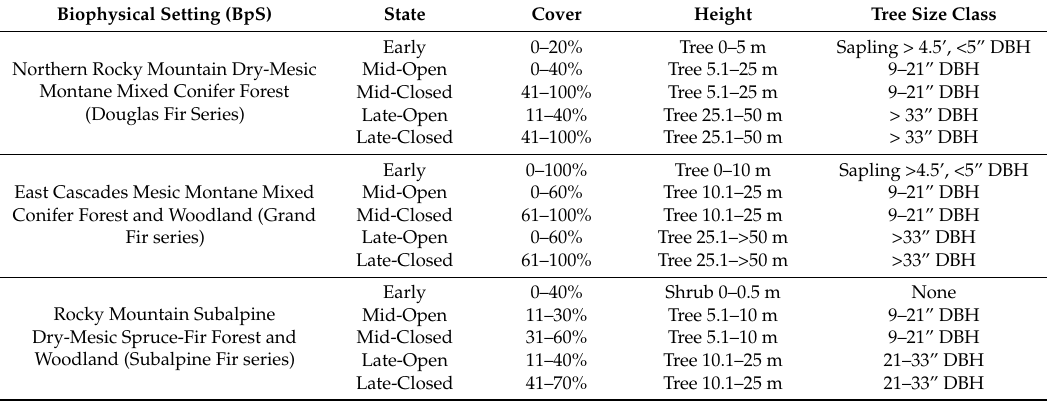
Table 4. Quantitative criteria and thresholds utilized to classify plots into the five successional states that describe the forest structure for the three Biophysical Setting (BpS) models present in the study area. Both the initial classification of the plots into BpS models and further classification into successional states also utilized qualitative information and species lists in the BpS model descriptions, which can be found on the LANDFIRE website